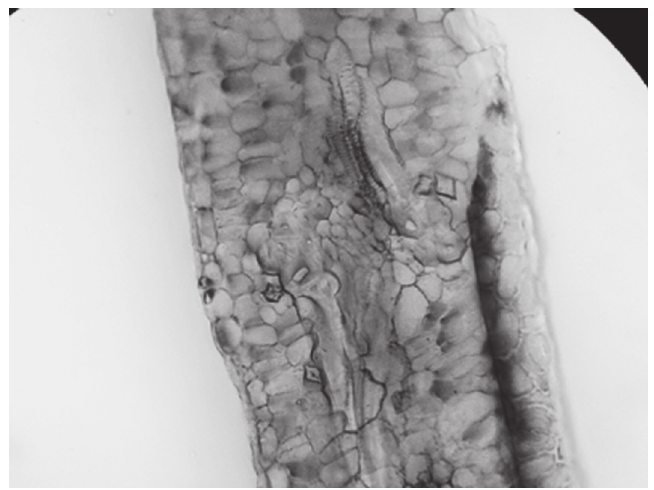
Figure 2 - Transverse section of the region between the midvein and the margin from the leaf of C. sylvestris var. lingua .